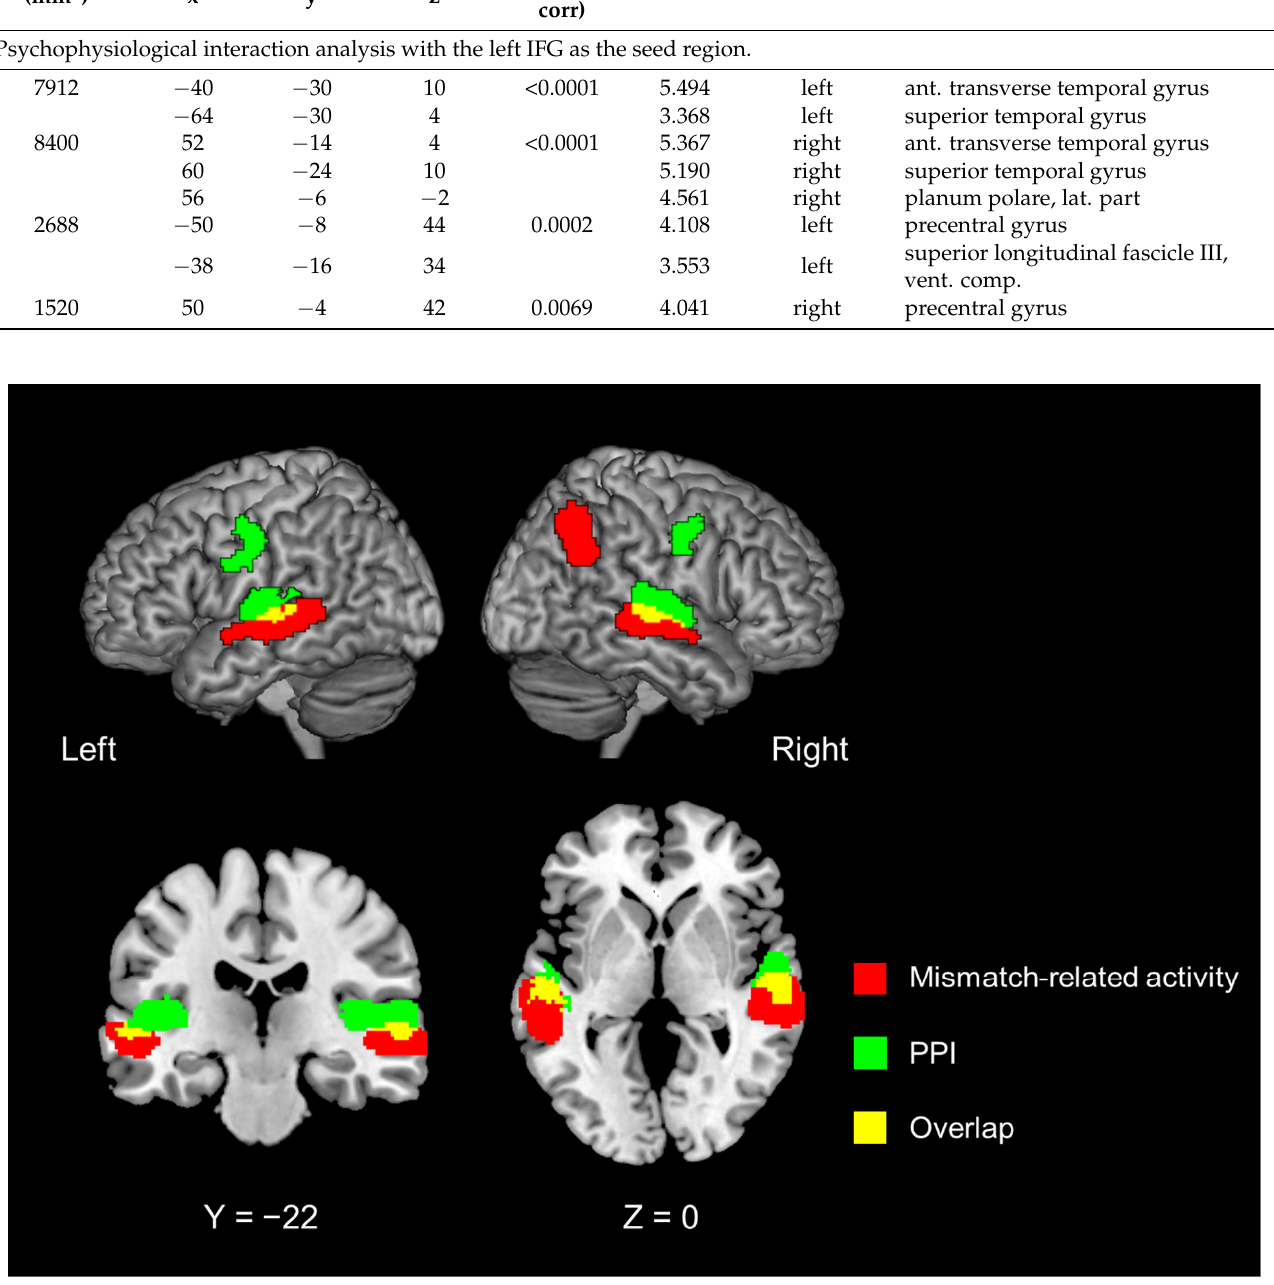
Figure 4. Mismatch-related brain activity, irrespective of introspection or object feature identification (Contrast #13, Table 1) (red region). Significant regions identified with psychophysiological interaction analysis with the left inferior frontal gyrus as the seed region (green region). Areas shown in yellow indicate an overlap between the two (red and green)